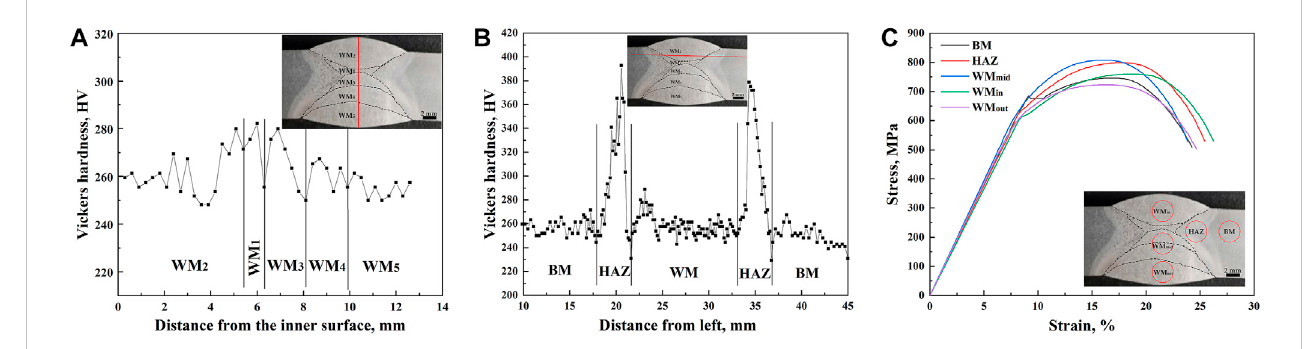
FIGURE 2 Curves of the hardness variation along the thickness (A) and transverse (B) direction and the stress – strain (C) of the welded joint.